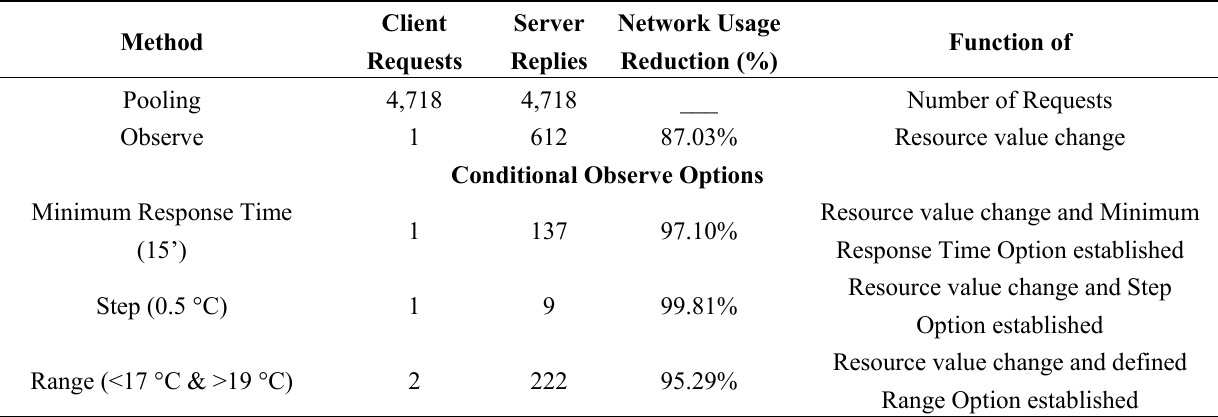
Table 5. Comparison between the different methods used for data